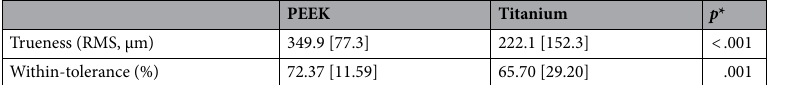
Table 3. Trueness (root mean square, µm) and within-tolerance (%) measurements according to scan body materials. Data are presented as median [interquartile range]. PEEK polyetheretherketone, RMS root mean square. *Mann–Whitney U